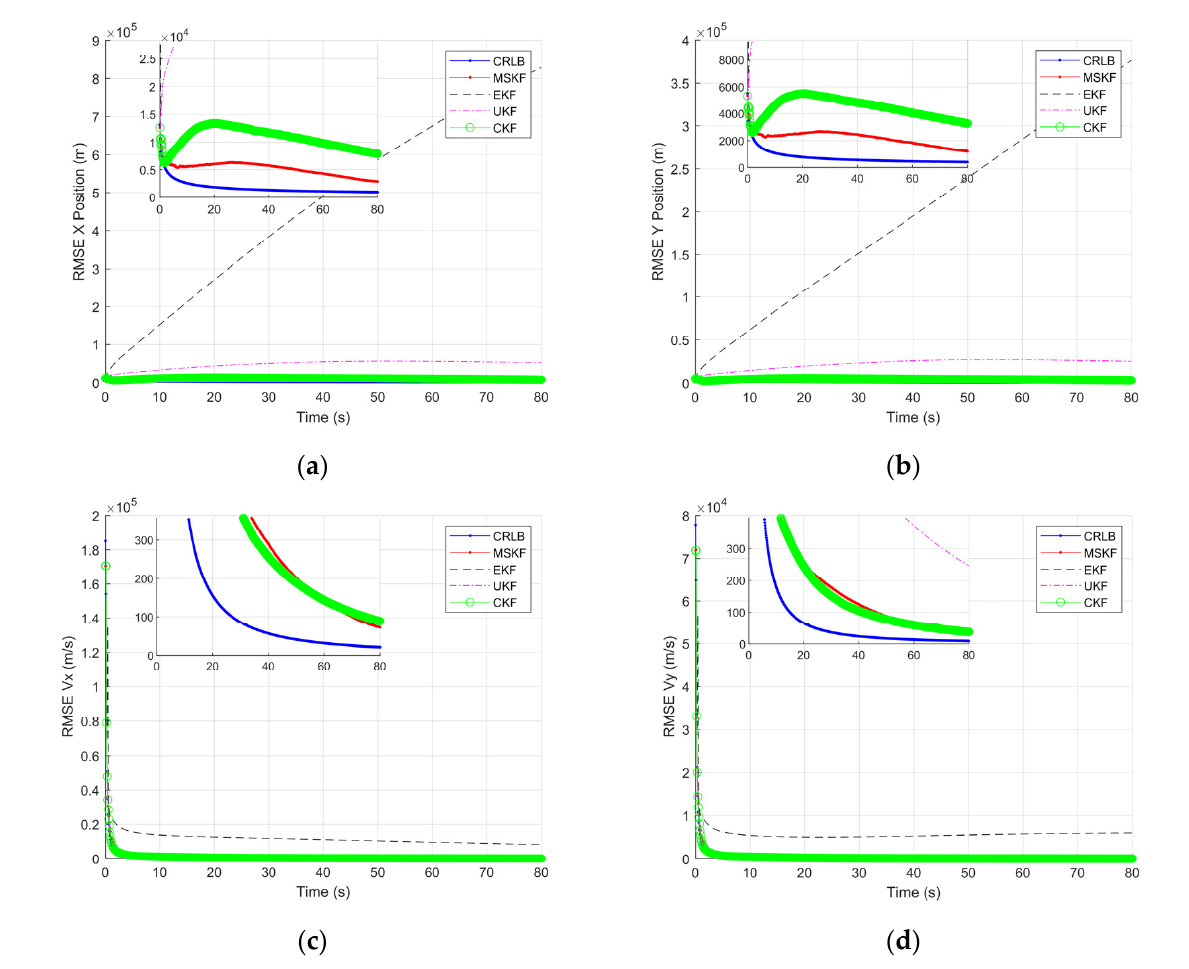
Figure 10. Comparison of state component RMSE and CRLB of CL distribution: ( a ) RMSE in X position; ( b ) RMSE in Y position; ( c ) RMSE in X speed; and ( d ) RMSE in Y speed.